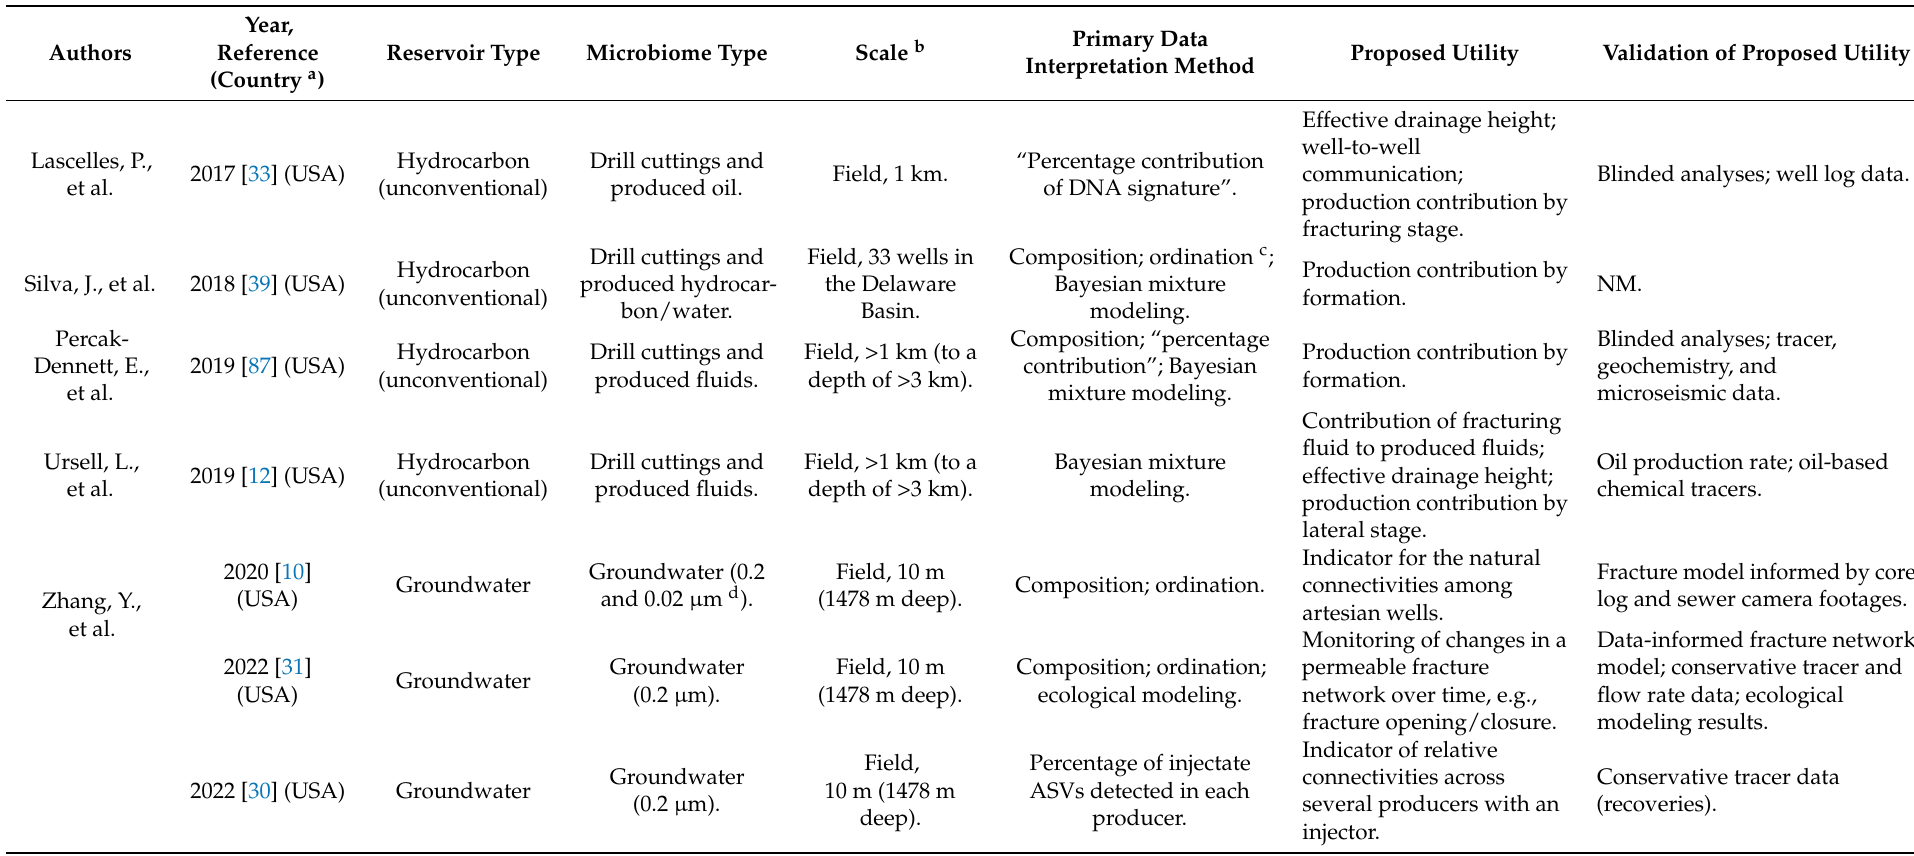
Table 3. Summary of the literature on the use of indigenous microbial communities as naturally occurring hydrogeological/reservoir tracers. Studies are grouped according to the first author and presented in chronological